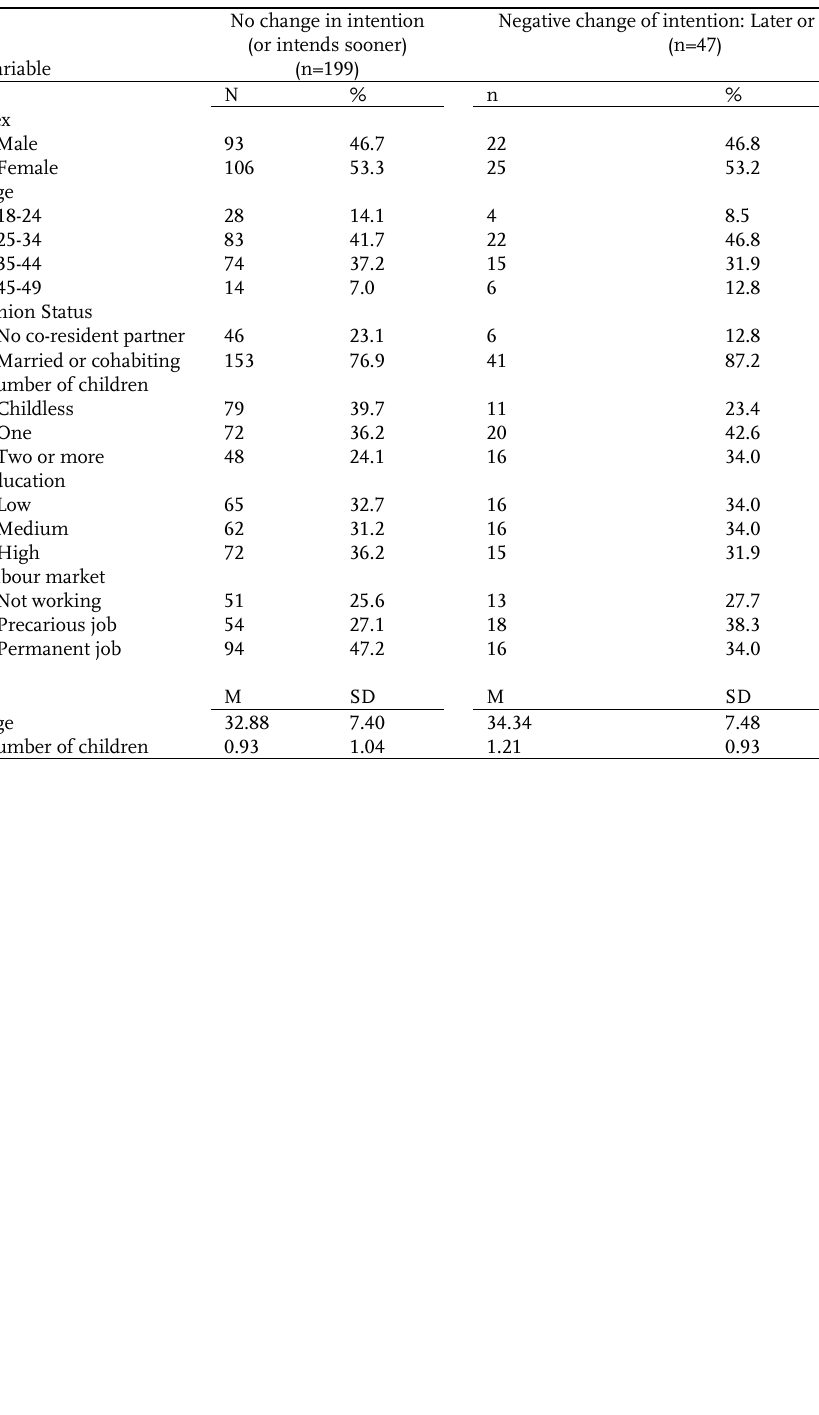
Table A.1 : The socio-demographic characteristics of the total sample (n=1000) and the analytic sample (n=246), divided by the declared impact of the pandemic on the respondents’ intention to have a child